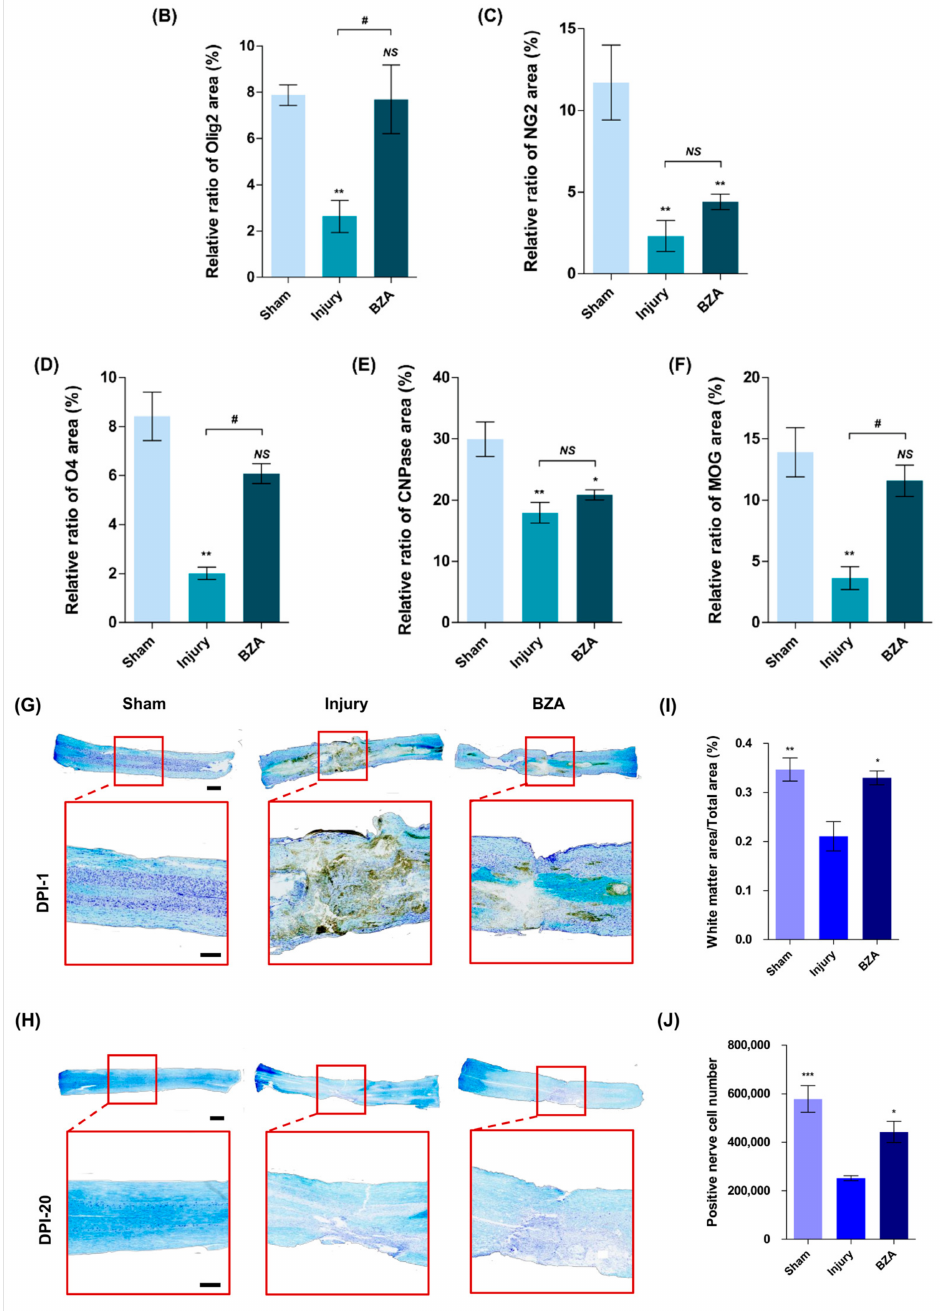
Figure 6. BZA enhances remyelination after SCI. For a quantitative analysis of the formation of oligodendrocytes responsible for myelination, the spinal cord samples at dpi 20 were sectioned and immunostained. ( A ) Representative images of oligodendrocyte differentiation marker Olig2, the mature oligodendrocyte markers NG2, O4, CNPase, and the myelin marker MOG in the sham, injury, and BZA groups. (B–F) The percentage (%) of each antibody area to the total area of the immunofluorescence (IF) quantification graph. ( B ) Olig2, ( C ) NG2, ( D ) O4, © CNPase. ( F ) MOG. ( G , H ) Representative images of Luxol fast blue (LFB) staining at dpi 1 and dpi 20 in the sham, injury, and BZA groups. ( I ) Percentage graph of white matter that could be confirmed as myelin compared to the total area of sham, injury, and BZA groups at dpi 20, ( J ) A graph confirming the number of positive cells representing nerve cells at dpi 20. IF results of the graph confirmed the significance between the sham group and the injury and BZA groups. (LFB results = injury vs. sham, BZA). Data represents mean ± SEM ( n = 3–4 ( B , C ), 3 ( D ), 5–6 ( E ), 3–6 ( F ), 4 ( G – J )/group). * p < 0.05, ** p < 0.01, *** p < 0.001 (sham vs. injury, BZA; ( A – F ), injury vs. sham, BZA; ( G – J ). # p < 0.05 (injury vs. BZA; ( A – F ), NS = Not significant, one-way ANOVA followed by the Bonferroni